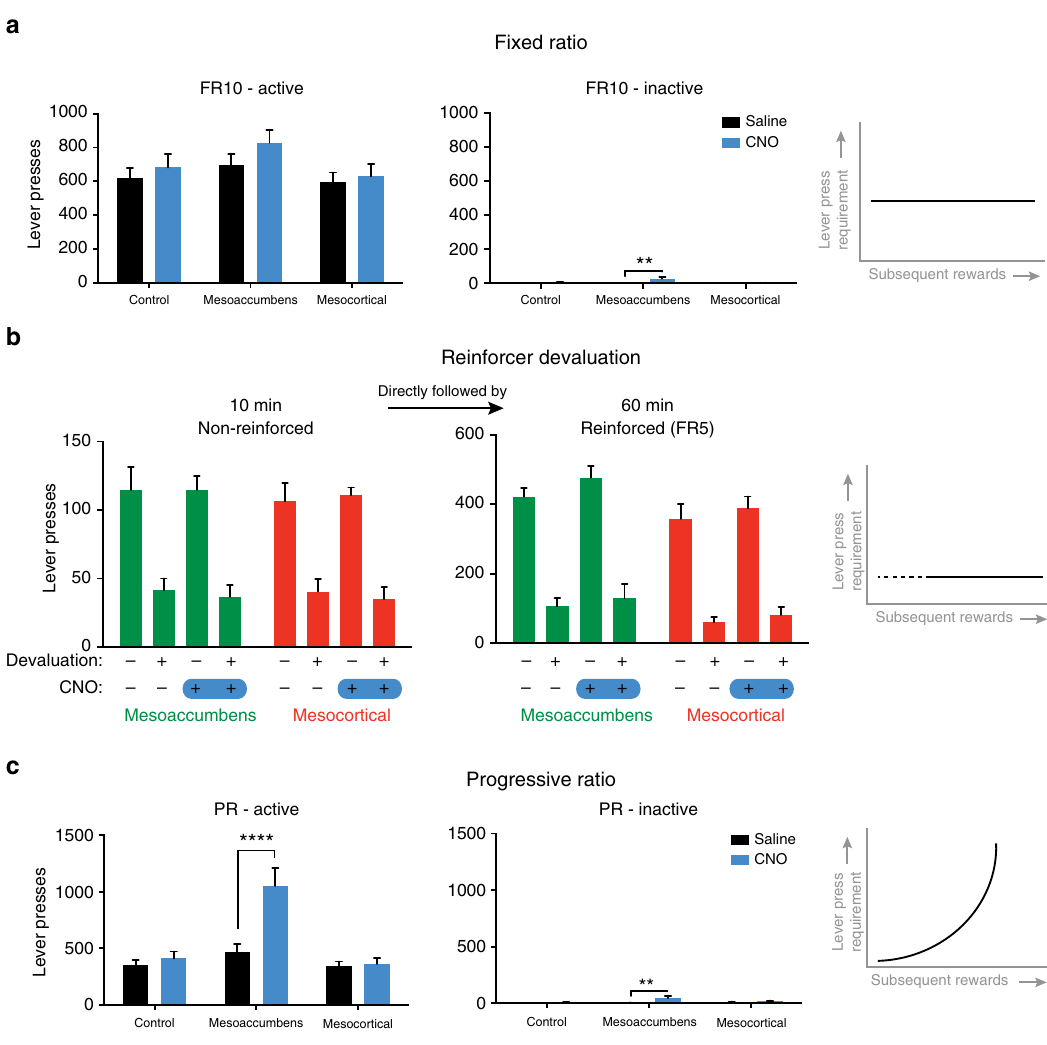
Fig. 5 Mesocortical and mesoaccumbens activation does not alter the static reward value of sucrose. a DREADD activation of either pathway did not affect the number of active lever presses under an FR10 schedule of reinforcement (two-way repeated ANOVA; effect of CNO, p = 0.0355; group×CNO effect, p = 0.5001; post-hoc test, CNO versus saline, all p > 0.1). A modest increase was observed in inactive lever presses after mesoaccumbens activation